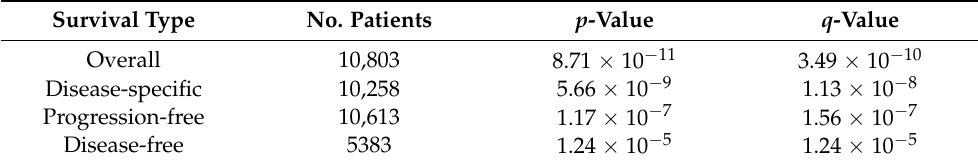
Table 1. Survival of cancer patients with TMPRSS2